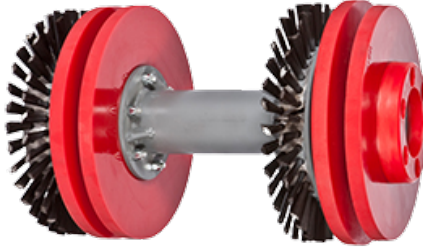
Figure 1. Example of cleaning